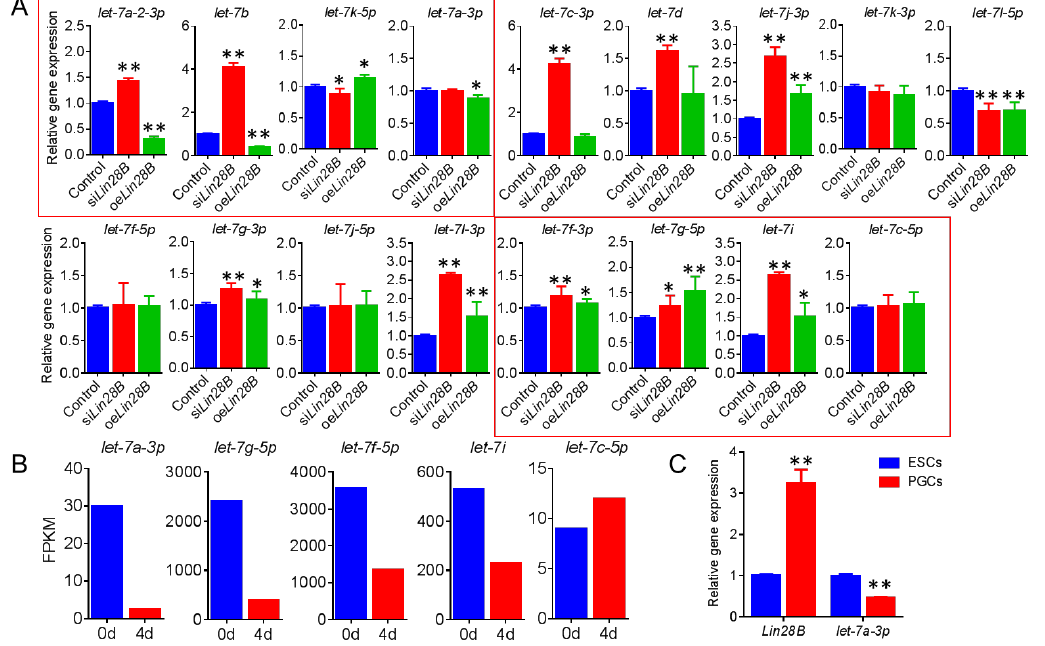
Figure 8. Lin28B promotes the formation of PGCs through the inhibition of gga-let-7a-3p . ( A ) qRT-PCR was used to detect the expression of let-7 family after overexpression and inhibition of Lin28B, only let-7a-2-3p , let-7a-3p , let-7b, and let-7k-5p showed opposite trend to Lin28B. ( B ) miRNA sequencing to screen let-7 ( let-7a-3p , let-7g-5p , let-7f-5p , let-7i , and let-7c-5p ) during the formation of PGCs in vitro. ( C ) qRT-PCR was used to detect the expression of let-7a-3p and Lin28B during the generation of PGCs in vivo. “*” means p < 0.05, and “**” means p < 0.01.